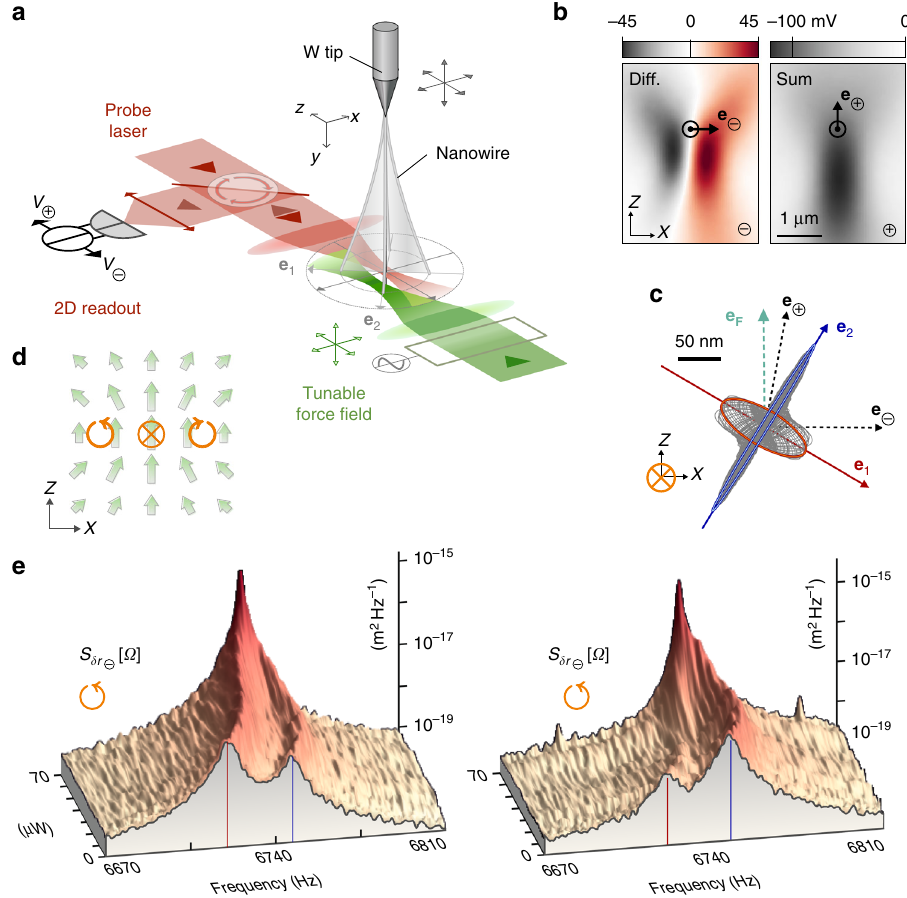
Fig. 1 The experiment. a The transverse vibrations of a singly-clamped nanowire are optically read out by focusing a red probe laser beam on its vibrating extremity while recording the re fl ected intensity fl uctuations on a dual photodetector. A counter propagating focused green laser beam generates a tunable optical force fi eld of non-conservative (rotational) nature 16 . b Horizontal, XZ maps of the sum/difference DC signals V (cid:3) = (cid:2) ð r Þ obtained by piezo-scanning the nanowire in the probe laser waist. The measurement location (cid:6) provides quasi-orthogonal projective measurement vectors e (cid:2) ; (cid:3) allowing for a 2D- measurement of the nanowire ’ s motion. c Steady-state driven trajectories obtained under resonant optical actuation at low optical power (2 μ W) for a set of driving frequencies spanning across both eigenfrequencies (300 trajectories (gray curves) from 6670 to 6810 kHz, the red/blue curves are the resonantly driven trajectories). e F : optical actuation force vector, e 1 , 2 : uncoupled eigenvectors. d Sketch of the optical force fi eld structure. Measurement positions indicated by (cid:8) ;; feature zero, positive and negative force fi eld rotational respectively. e Calibrated thermal noise spectra measured on